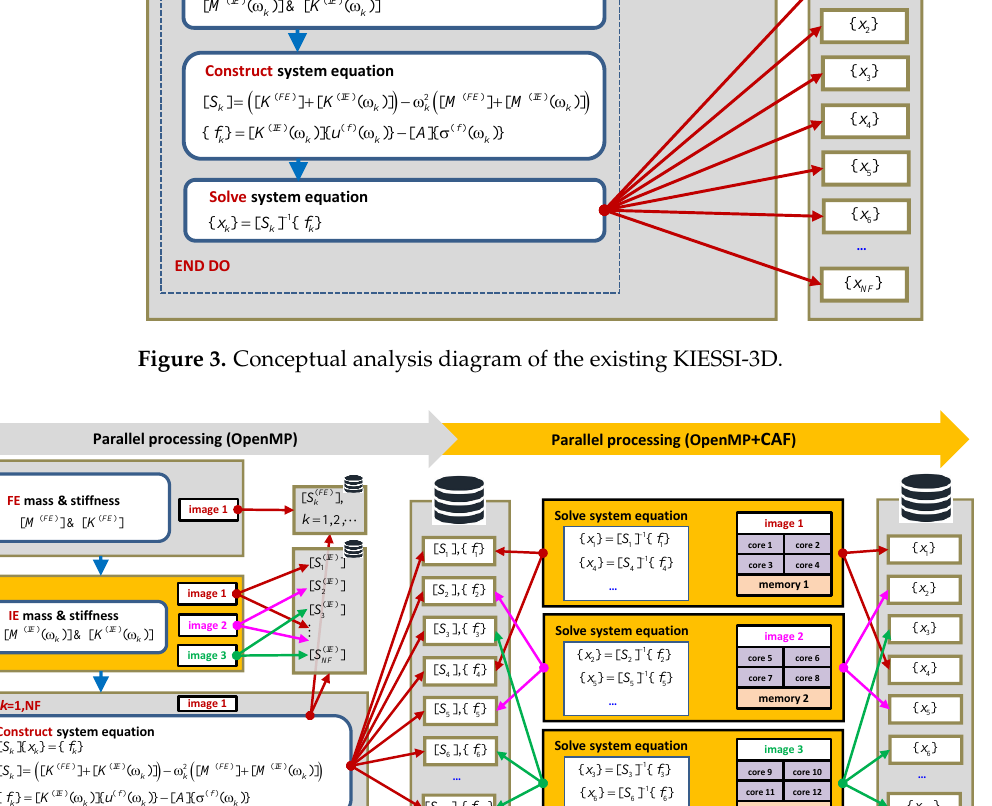
Figure 4. Conceptual diagram of the proposed KIESSI-3D with CAF incorporated (e.g. with a three coarray, 12-core computer system): Orange boxes represent accelerated parallelization by CAF combined with OpenMP, gray boxes represent parallelization using OpenMP only. NF denotes the number of frequency points to be analyzed.